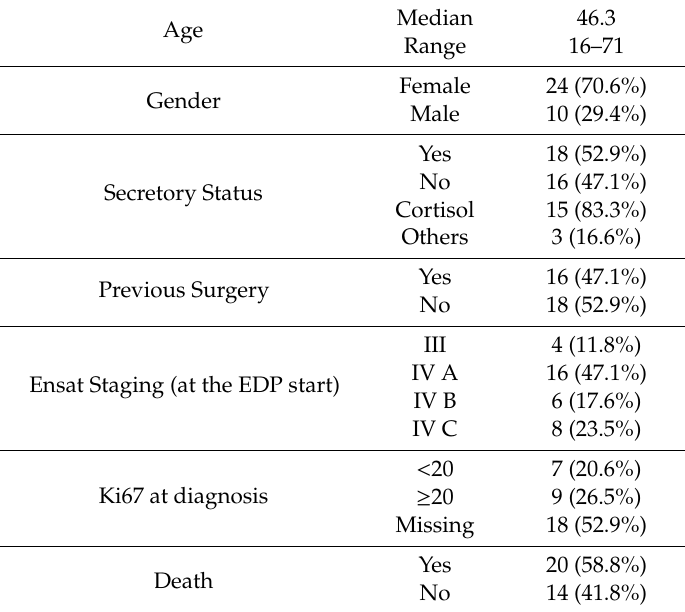
Table 1. Patients demographics and clinical